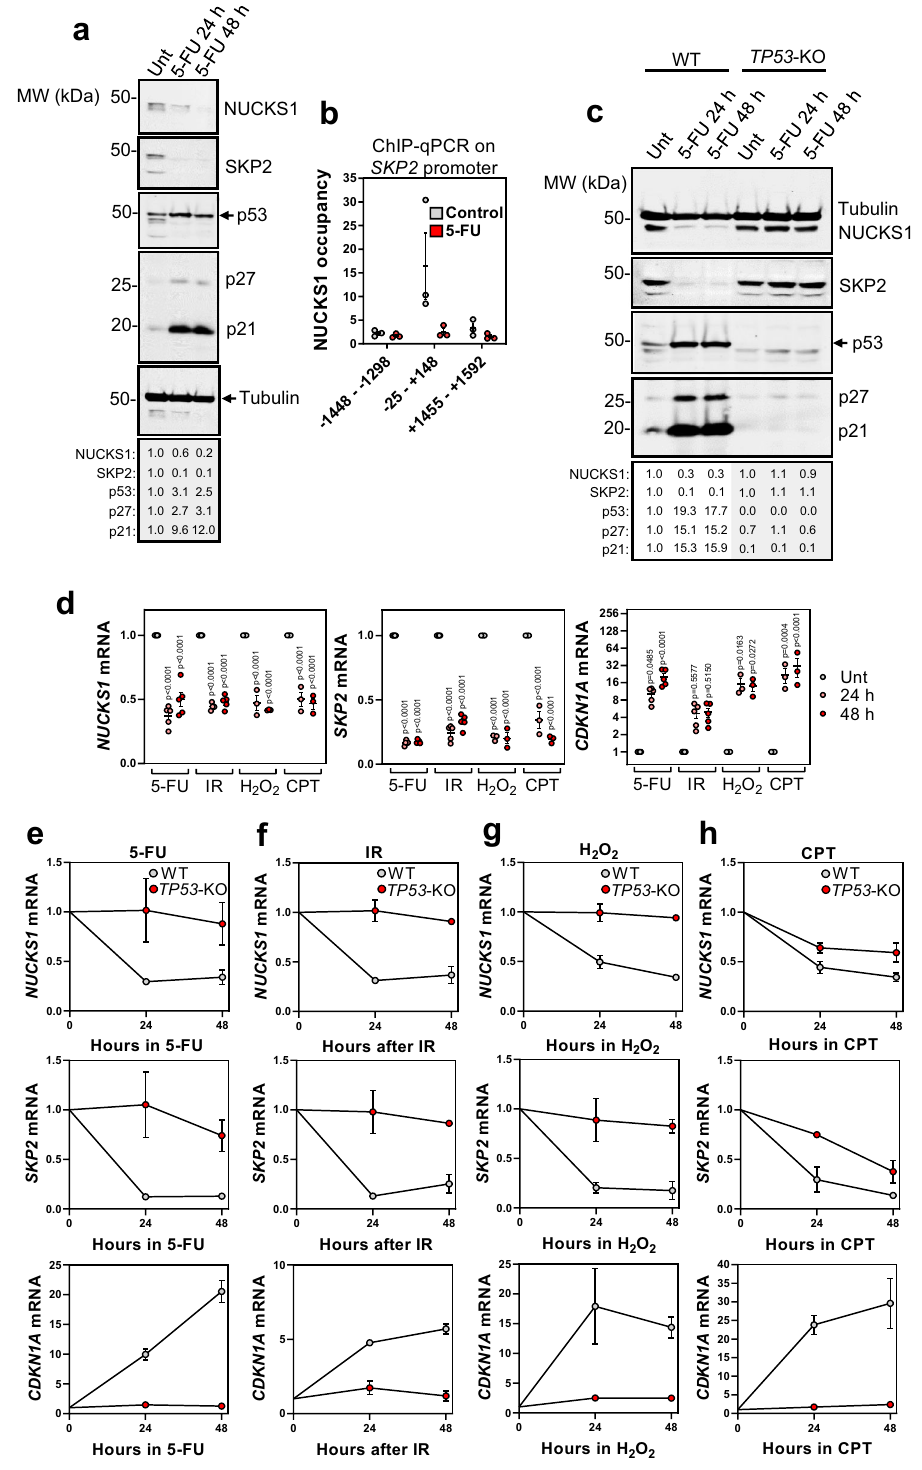
Fig. 5 DNA damage inhibits the NUCKS1-SKP2 axis through p53-mediated transcriptional repression. a Western blot in WT U2OS cells treated with 50 µ M 5-FU for 24 or 48 h. b ChIP-qPCR of NUCKS1 fold enrichment over IgG ( = 1) on the SKP2 promoter in U2OS cells after treatment with control or 50 µ M 5-FU for 48 h. c Western blot in RPE1-hTERT WT and TP53 -KO cells treated with 10 µ M 5-FU for 24 or 48 h. d RT-qPCR in WT RPE1-hTERT cells treated with 5-FU (10 µ M), IR (4 Gy), H 2 O 2 (200 µ M), or CPT (100 nM) for 24 or 48 h. Ordinary two-way ANOVA with Dunnett ’ s multiple comparisons test. e RT-qPCR after 5-FU (10 µ M) in RPE1-hTERT WT or TP53 -KO cells. f RT-qPCR after IR (4 Gy) in RPE1-hTERT WT or TP53 -KO cells. g RT-qPCR after H 2 O 2 (200 µ M) in RPE1-hTERT WT or TP53 -KO cells. h RT-qPCR after CPT (100 nM) in RPE1-hTERT WT or TP53 -KO cells. In a and c , data